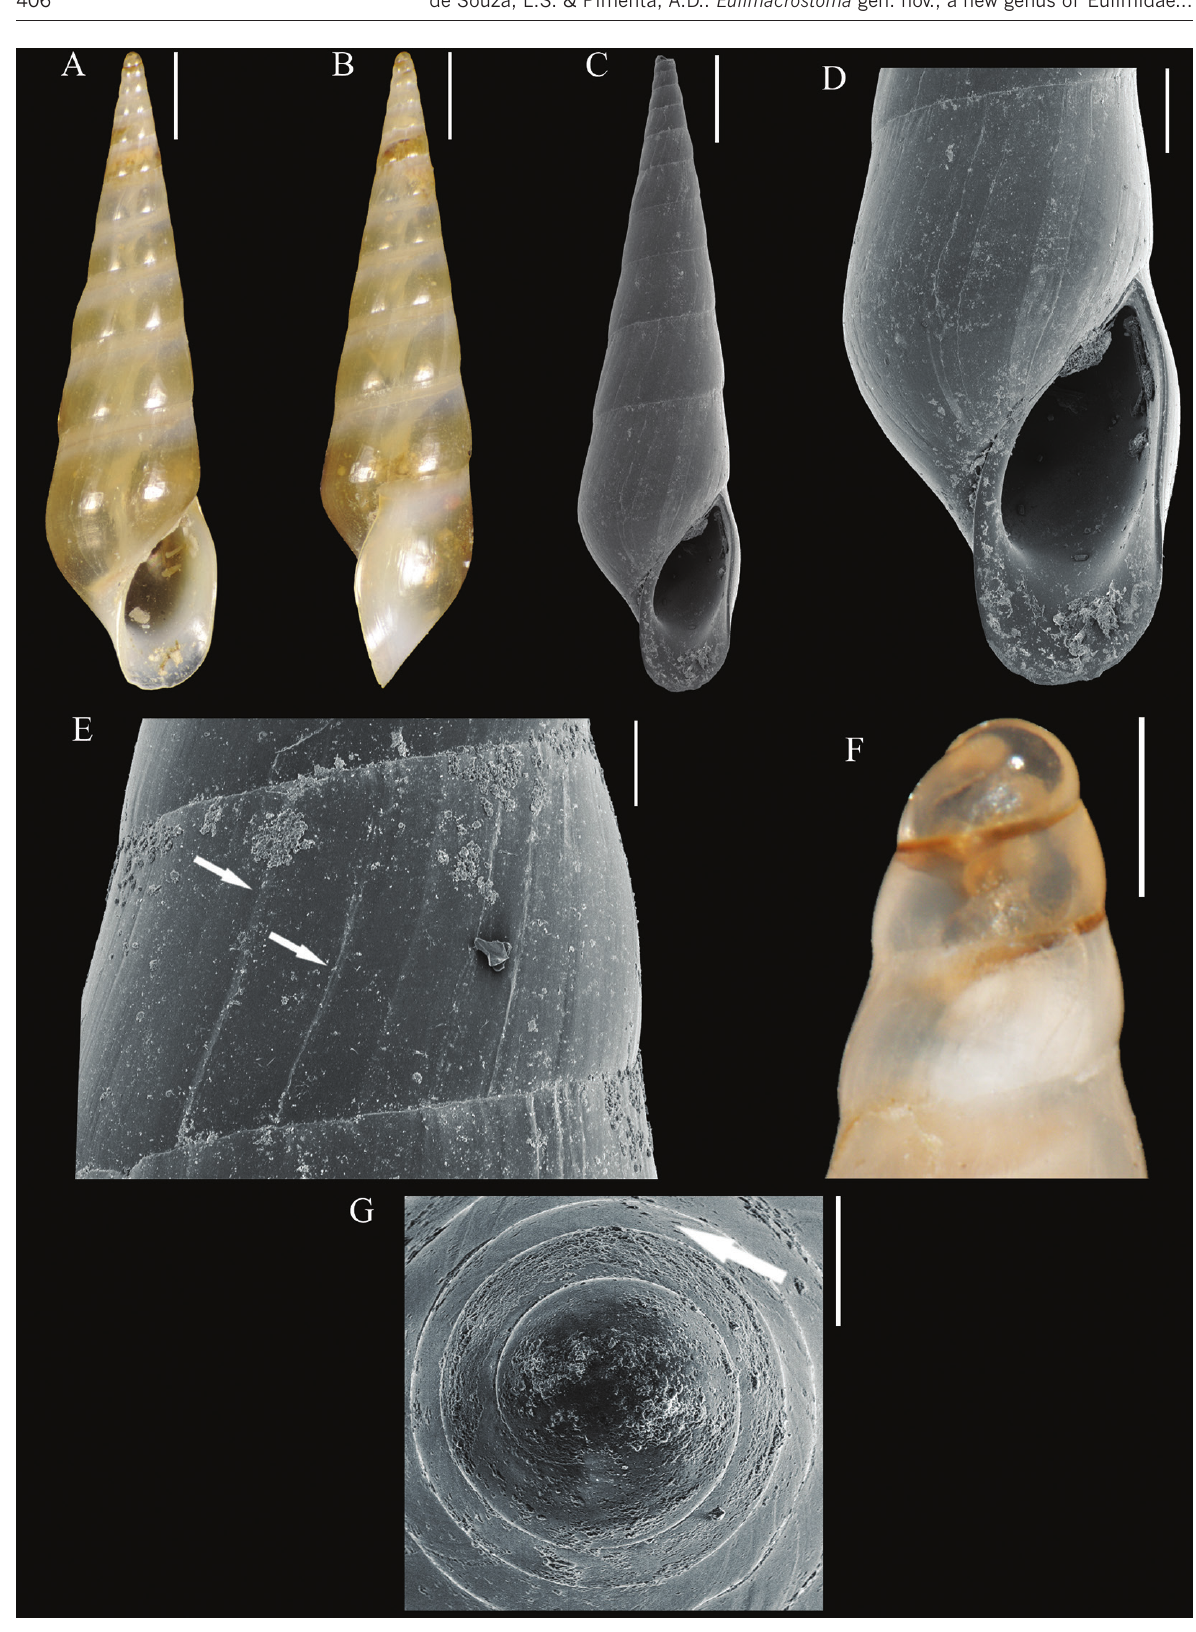
Figure 2. Eulimacrostoma microsculpturata gen. nov. and sp. nov. A–E. Paratype (ANSP 312431); F. Paratype (USNM 433081); G. Paratype (USNM 417511). A, C. whole shell in ventral view; B. Shell in lateral view; D. Detail of body whorl in frontal view; E. Detail of teleoconch surface, white arrows indicates the microsculpture of axial lines; F. Detail of apical whorls in frontal view; G. Detail of protoconch in apical view, white arrow indicates the transition protoconch-teleoconch. Scale bars: 1 mm (A–C); 500 µm D); 100 µm (E, G); 200 µm